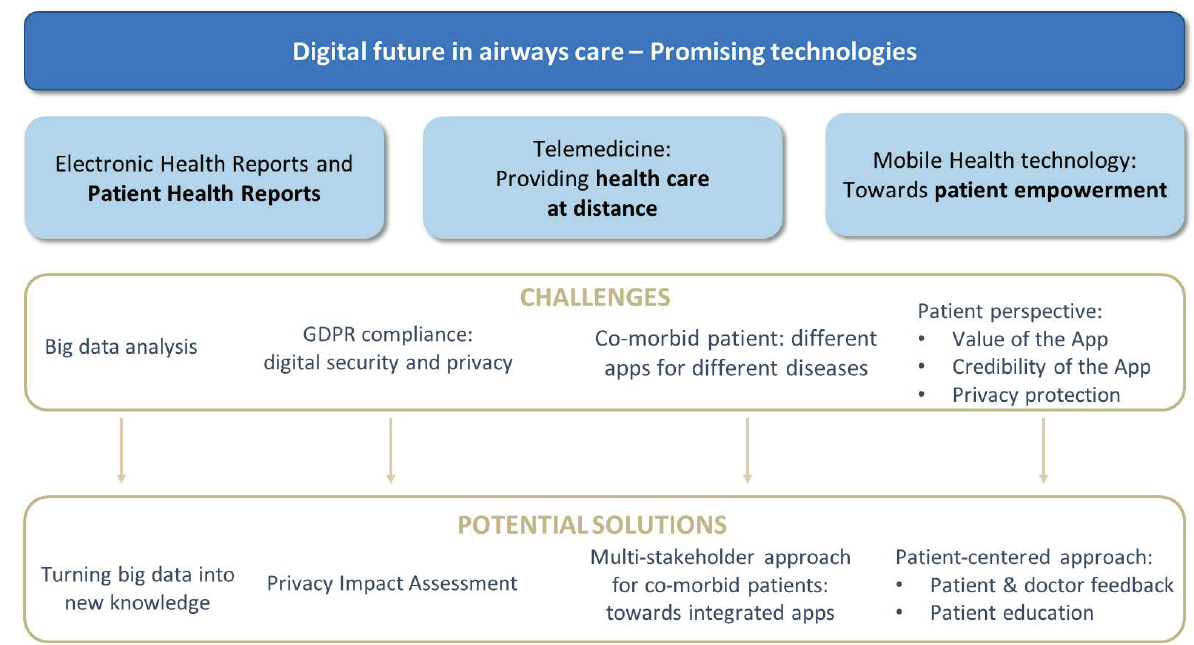
Figure 4. Digital future for airways